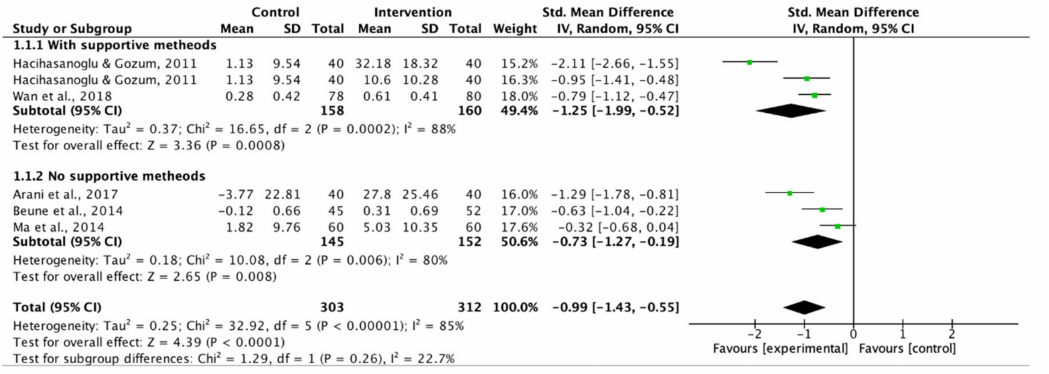
Figure 3. Forest plot of supportive methods on overall adherence to lifestyle modifications.